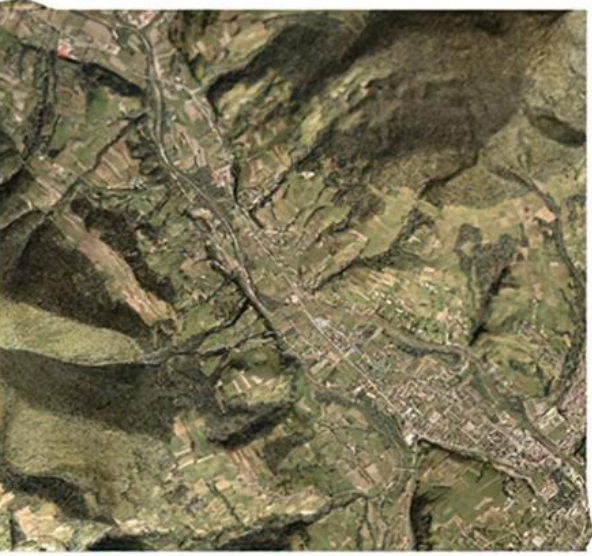
Figure 25. Area of elaboration — DTM model with superimposed texture, bird ’ s eye view.